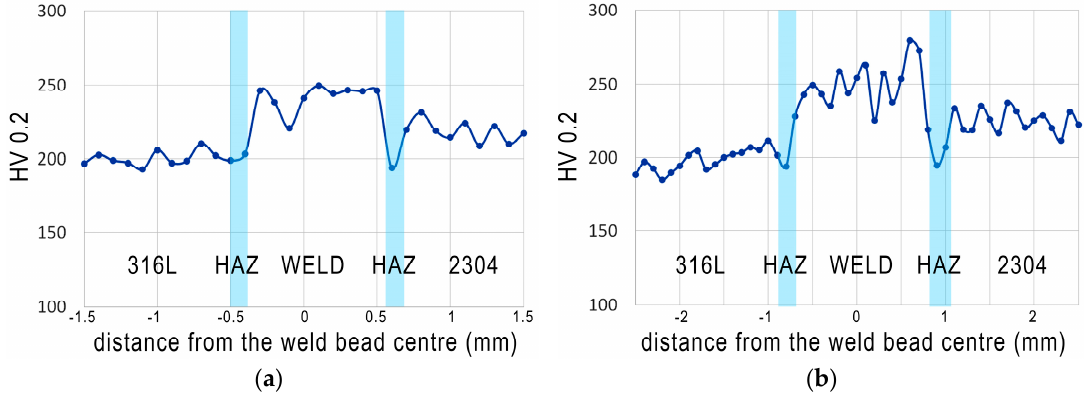
Figure 10. Microhardness (HV0.2) distribution across the welded joint: ( a ) 2 mm below the weld face and ( b ) 2 mm above the weld root.